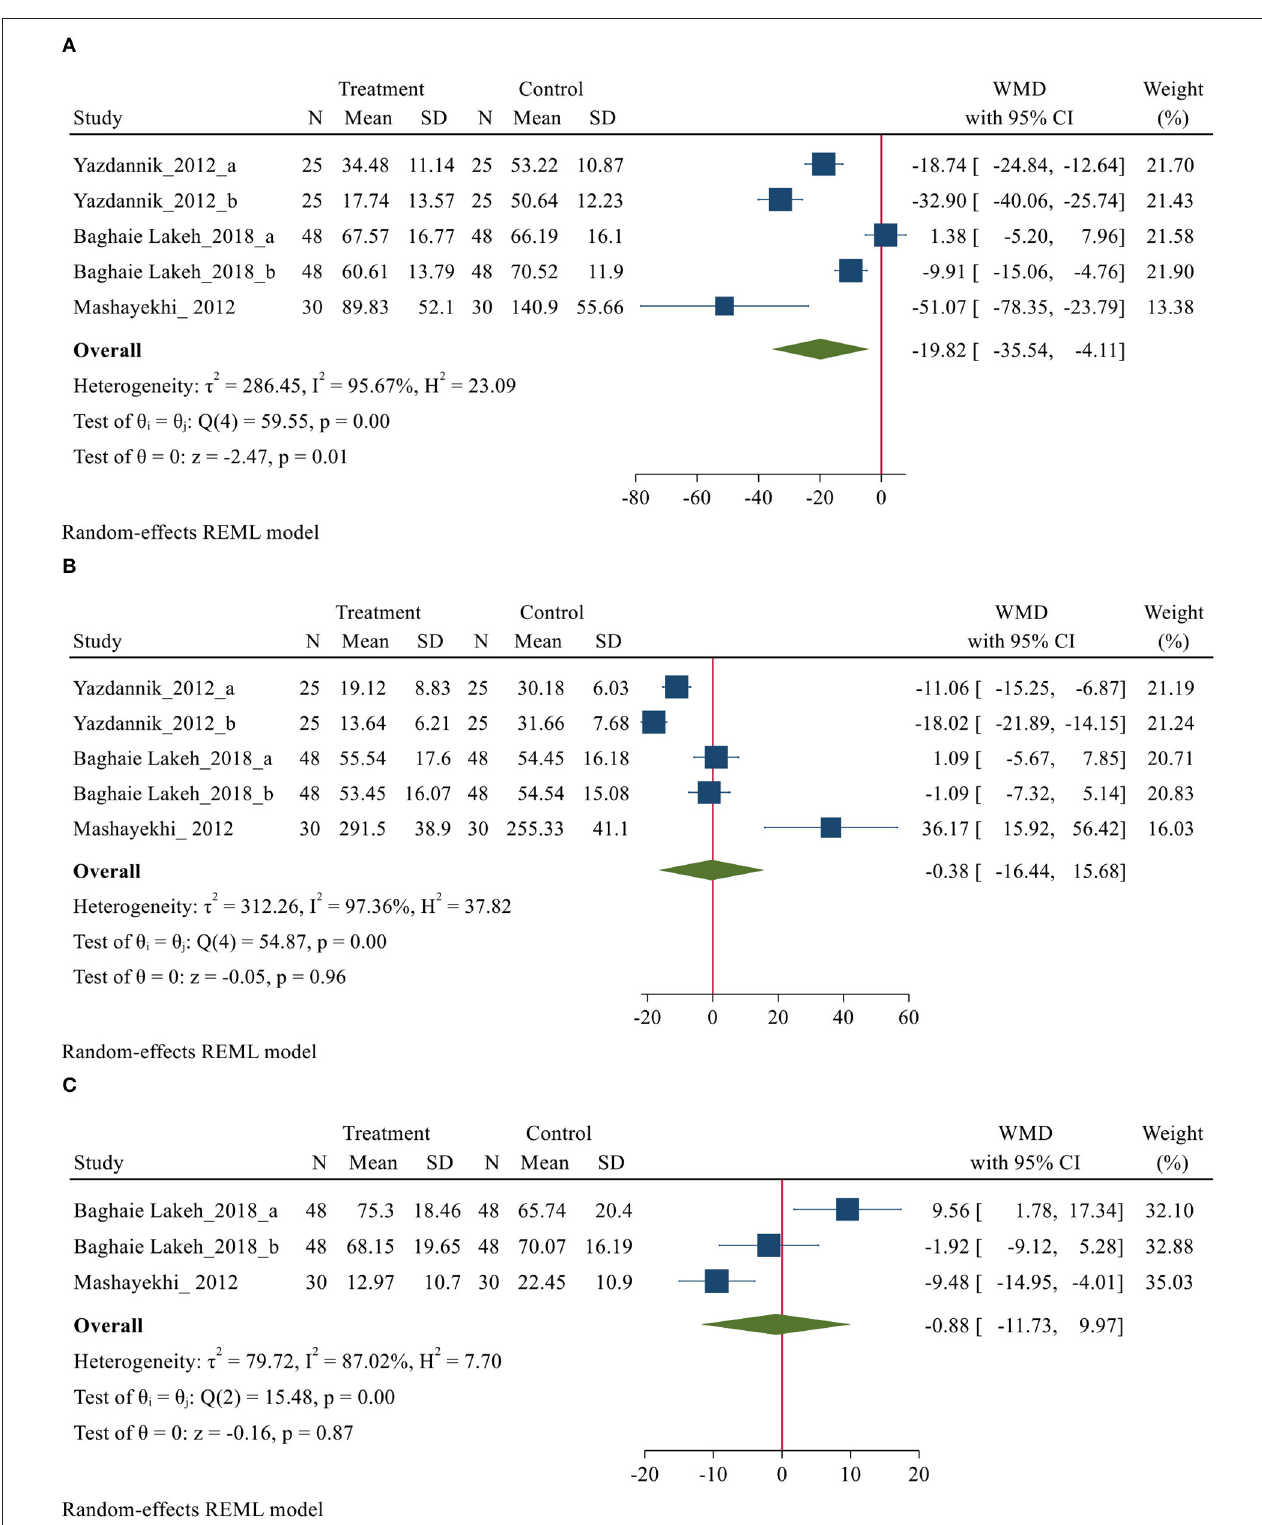
FIGURE 4 | Forest plot of mean difference (MD) for sleep quality domains based on VSHSS between intervention and control groups, (A) disturbance; (B) effectiveness and (C) supplementary.